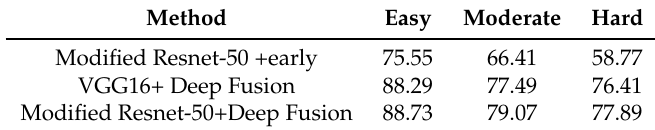
Table 5. Average precision (AP) (in %) for BEV boxes for ablation studies.